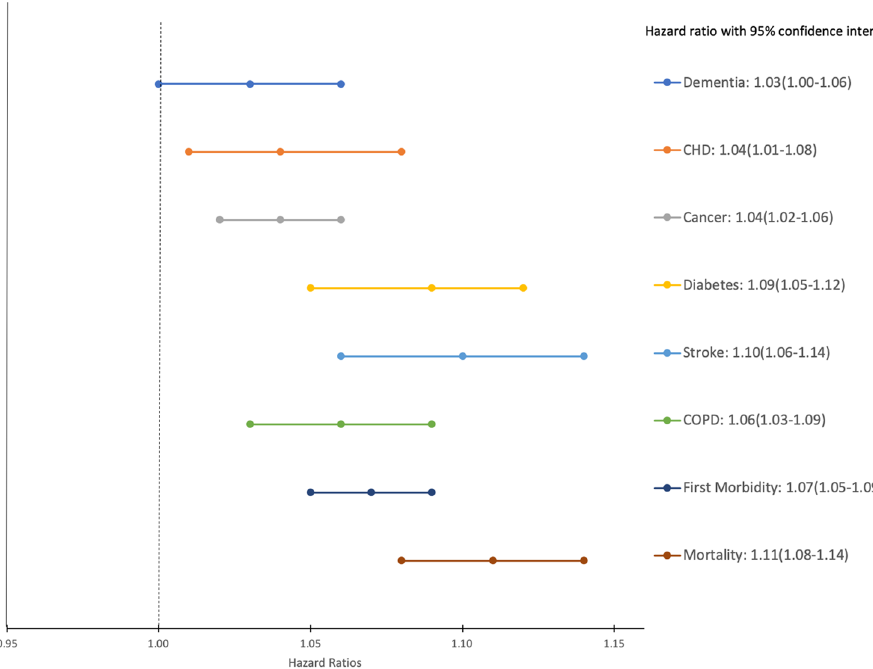
Figure 1. Association of BioAge1 and risk of morbidities /mortality, with adjustment for chronological age, APOE -ε 4 and gender, the Rotterdam Study, 2002–2012.